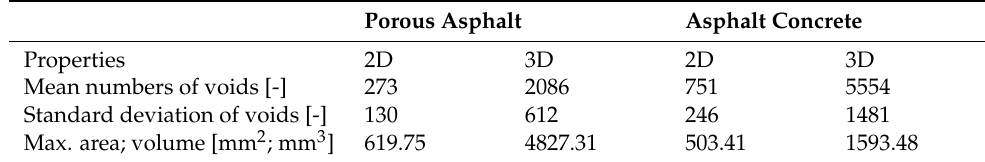
Figure 11. Visualized void distribution of the µ -CT scan—asphalt concrete; volume: 43,173.6 mm 3 . Table 6. Results of the 2D method and the 3D method. Porous Asphalt Asphalt